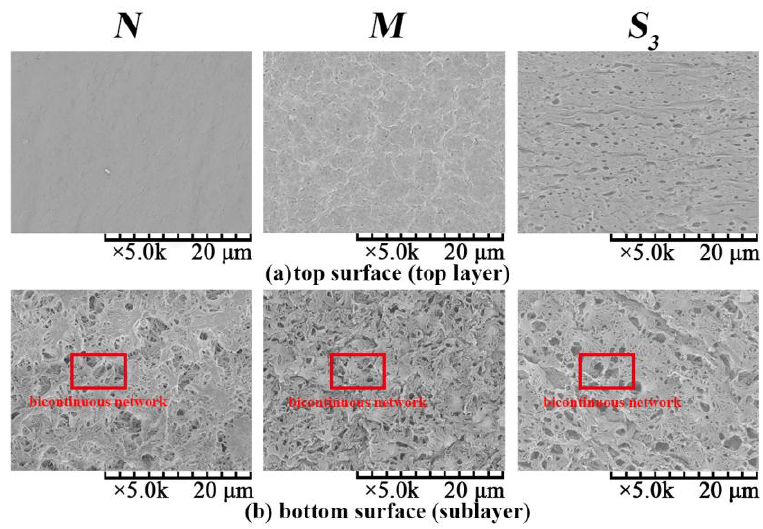
Figure 7. SEM images of membrane top and bottom surfaces of N , M and S 3 : ( a ) top surface (top layer); ( b ) bottom surface (sublayer).